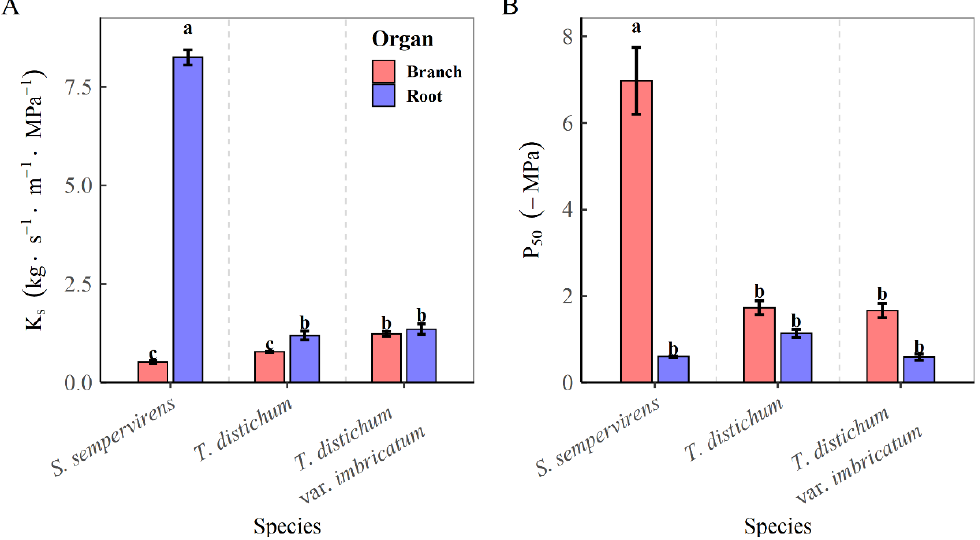
Figure 1. Species-specific sapwood conductivity ( K s ), ( A ) and water potential at 50% loss of hydraulic conductivity ( P 50 ), ( B ) in the branches and roots. P 50 values were converted from negatives to positives. Different letters indicate a significant difference between means at p < 0.05 (multiple comparisons of treatments by means of a Tukey